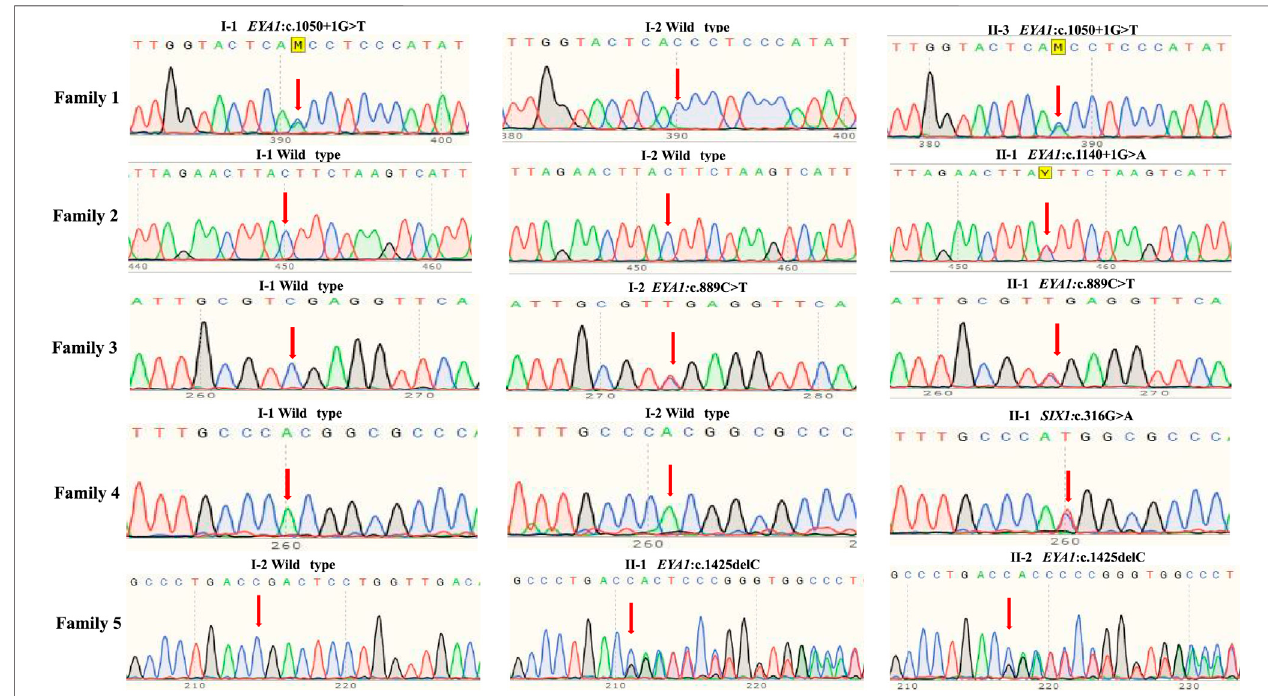
FIGURE 2 | Sanger sequencing of fi ve unrelated families with BOR or BOS. Normal family members harbored no mutations in EYA1 or SIX1 gene.